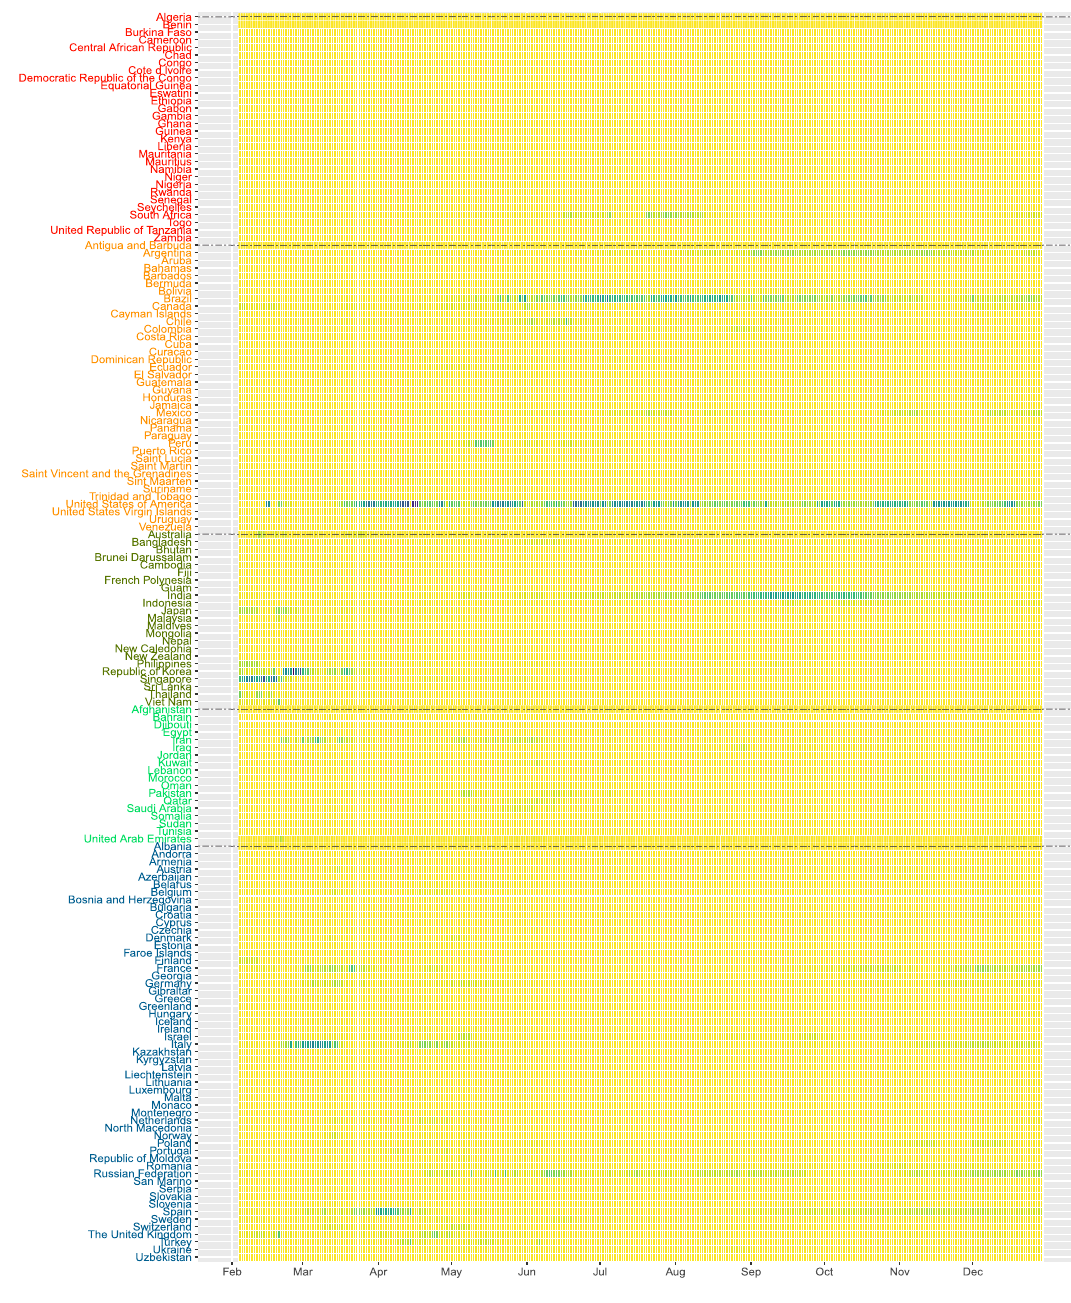
Figure 6. The heatmap of the risk contribution g it based on the severity risk score S 2 t for the 164 countries from February to December